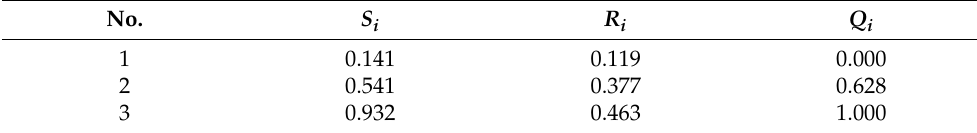
Table 4. S i , R i and Q i of each